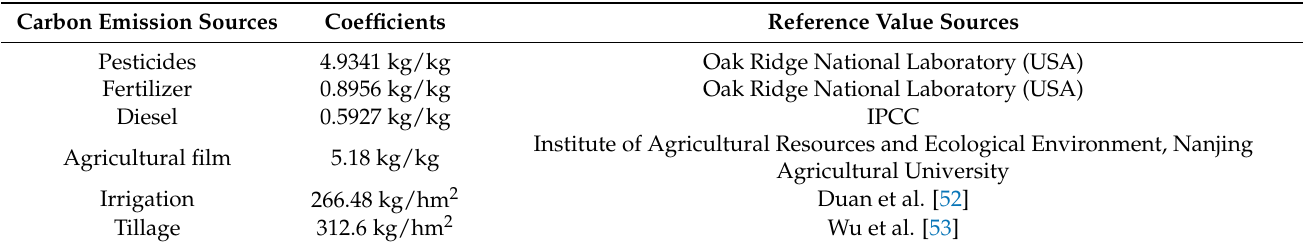
Table 2. Basis for determining carbon emission coefficients for agriculture.